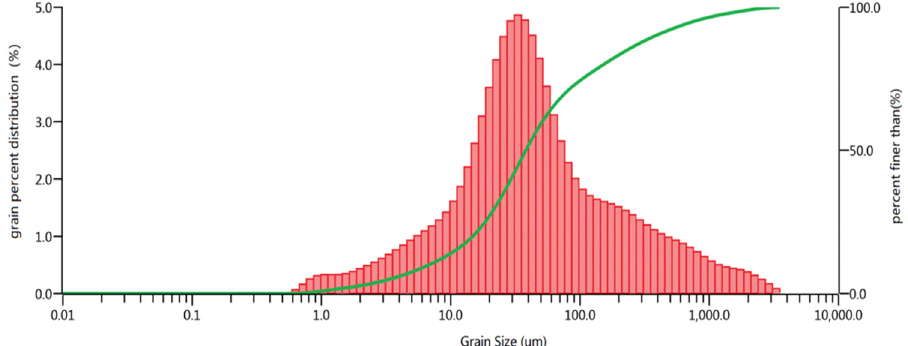
Figure 1: Grain - size distribution of Shanghai clayey soil.